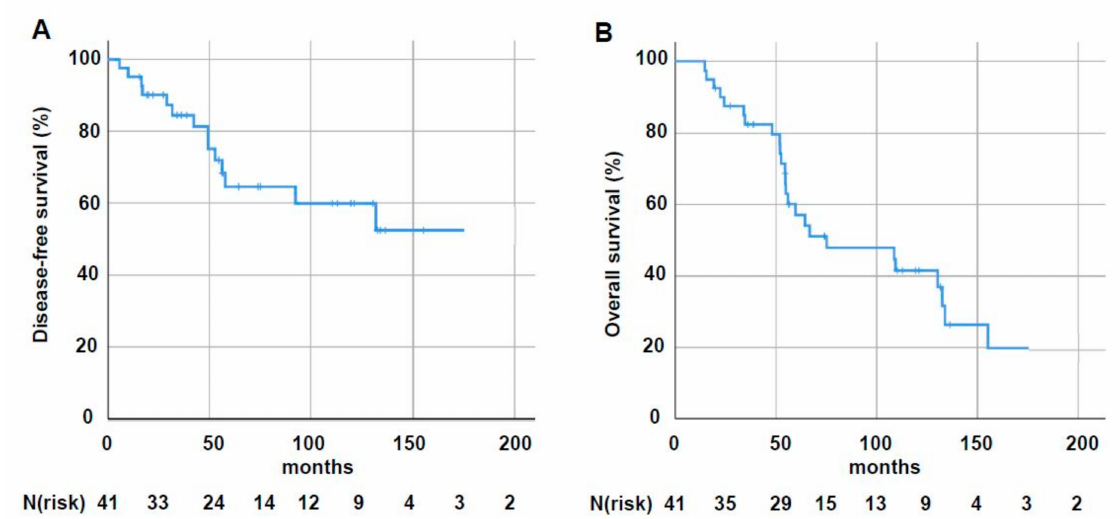
Figure 2. Kaplan–Meier-estimated disease-free ( A ) and overall ( B ) survival following surgical resection and postoperative radiotherapy for